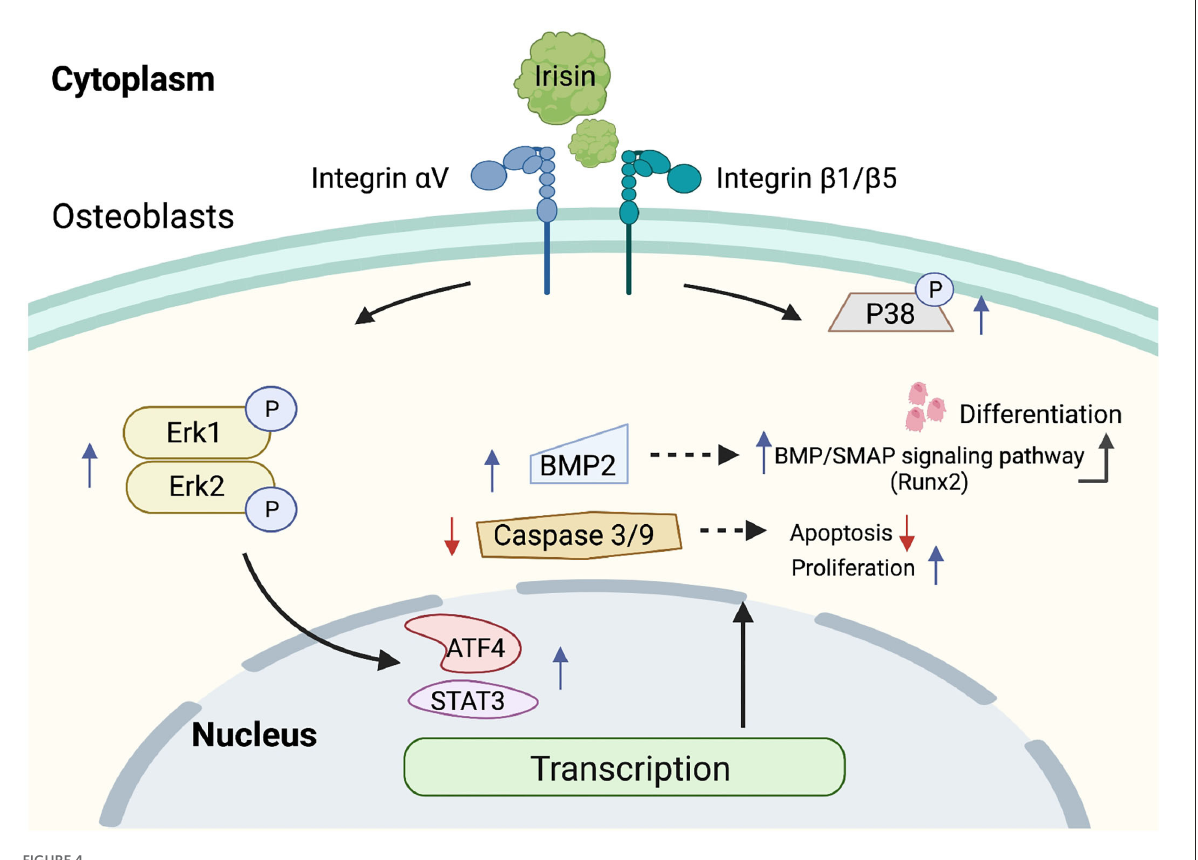
FIGURE4 Mechanism of regulation of ERK MAPK signaling pathway by irisin. Irisin binds to integrins, increases the amount of p-P38 and p-Erk1/2, activates the ERK MAPK signaling pathway, resists apoptosis, promotes proliferation, and induces osteoblast differentiation.